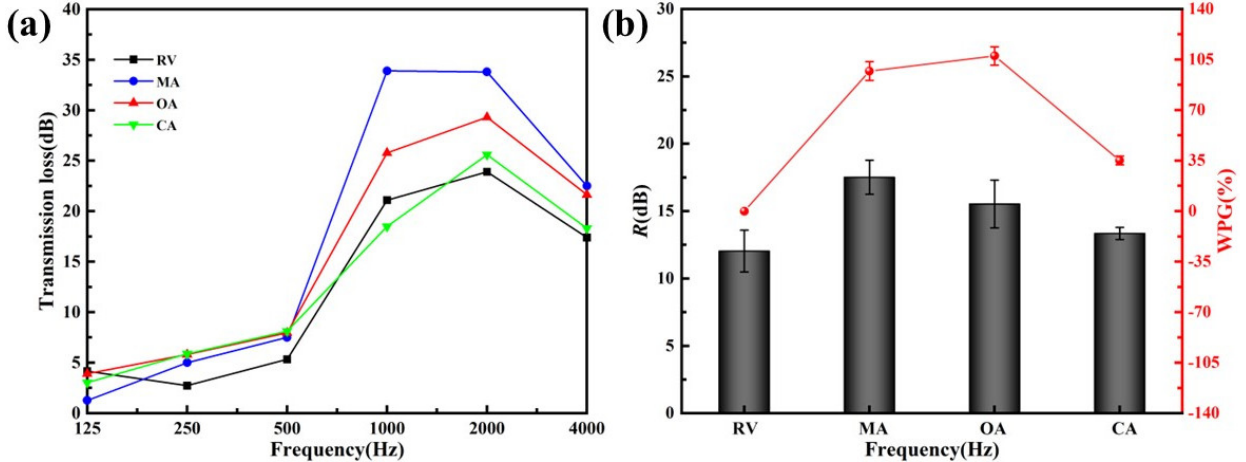
Figure 4. Sound insulation of unmodified veneer and FA-modified veneer with different acid catalysts ( a ) transmission loss dependent on the frequency; ( b ) average sound insulation and WPG.